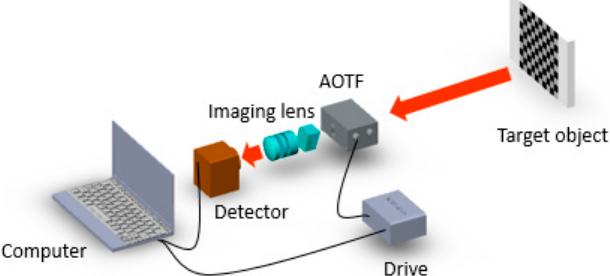
Figure 2. Simplified structure of the traditional short-wave infrared (SWIR) AOTF imaging spectrometer. The focal length of the imaging lens is 73 mm. The AOTF aperture is an aperture stop in the system. The AOTF and the detector are controlled by software. The target object is a checkerboard.